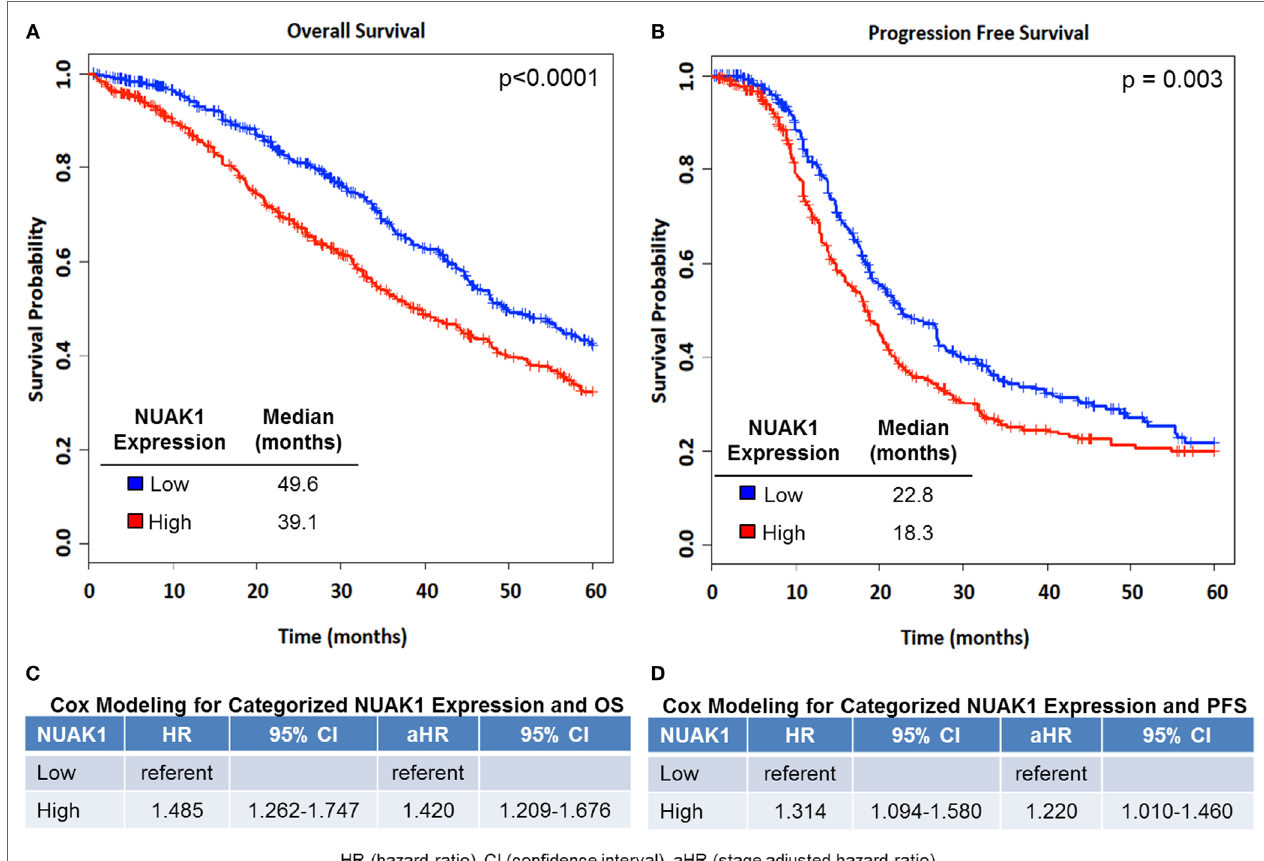
FigUre 1 | elevated nUaK1 expression is associated with poor overall and progression-free survival in high-grade serous ovarian cancer patients . Kaplan–Meier (KM) plots of NUAK1 transcript expression and cox regression results of categorized NUAK1 expression relative to patient survival. (a) Overall survival (OS, NUAK1 continuous multivariate HR = 1.19, p -value = 3.03E − 07, n = 1,262). (B) Progression-free survival (PFS, NUAK1 continuous multivariate HR = 1.42, p -value = 2.19E − 05, n = 802). (c) Cox regression results of categorized NUAK1 levels versus OS. (D) Cox regression results of categorized NUAK1 levels versus PFS. p -value insets derived from Log-Rank